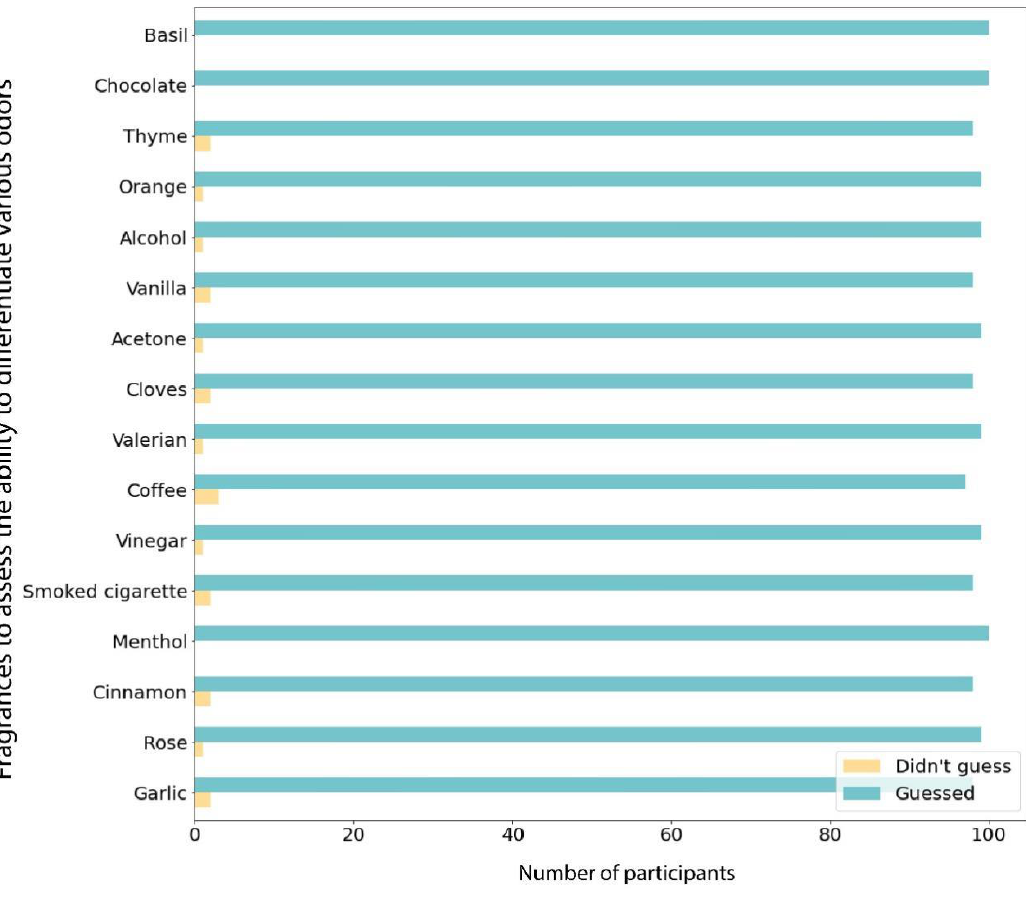
Figure A2. Olfactory differentiation ability among the healthy pretested population.